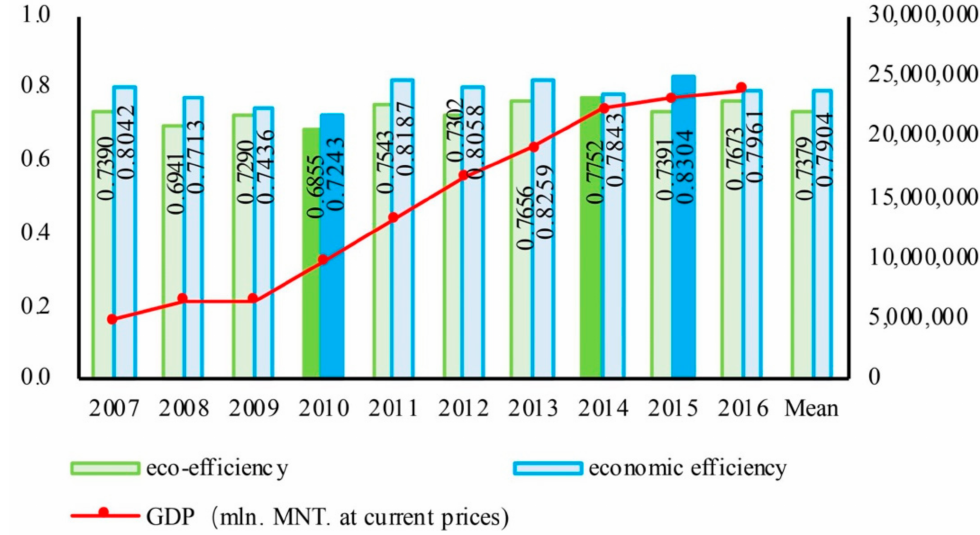
Figure 2. Trend of eco-efficiency and economic efficiency in Mongolia from 2007 to